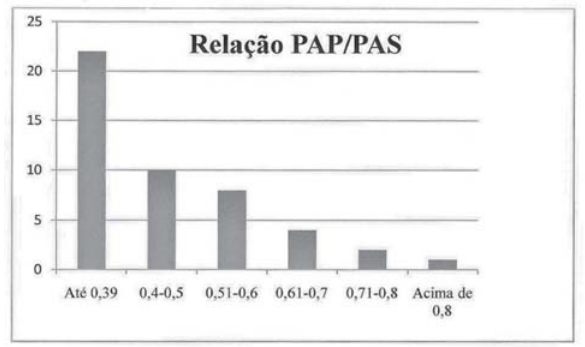
Fig. 2 - Relação pressão arterial pulmonar/pressão